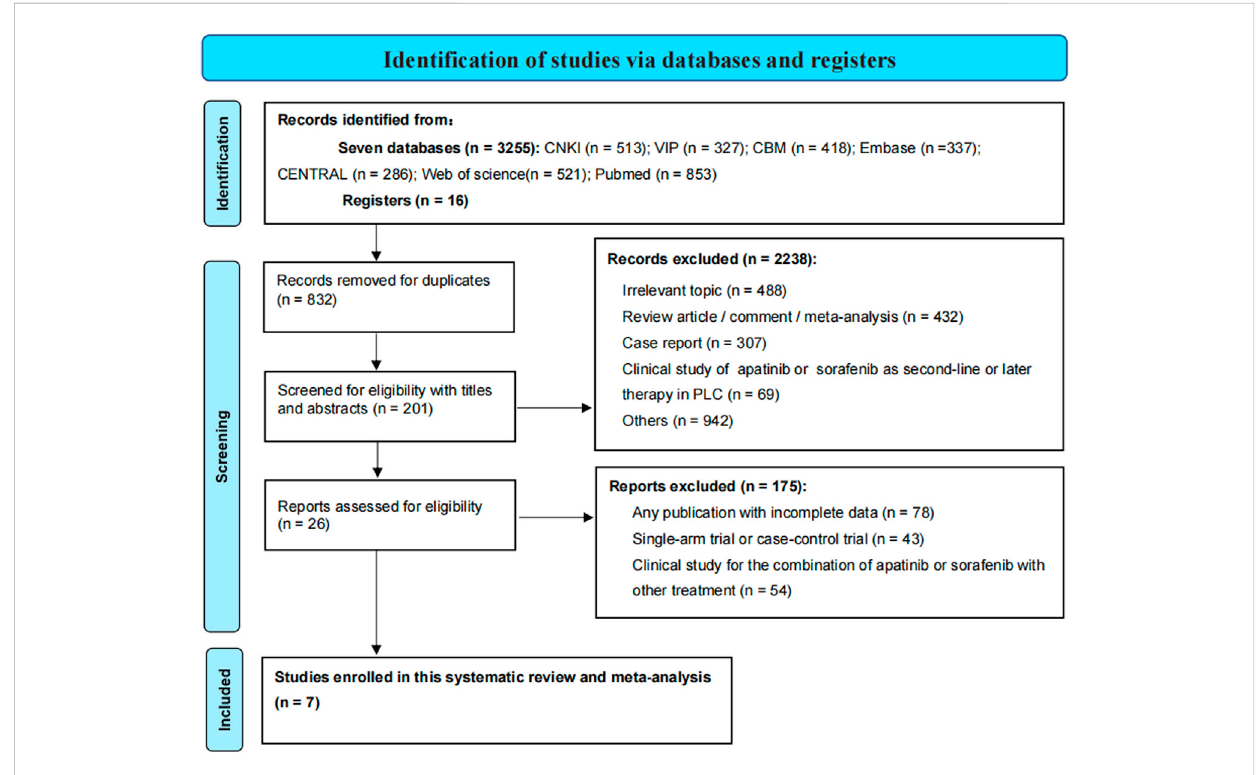
FIGURE 1 PRISMA fl owchart for selection of relevant studies in this